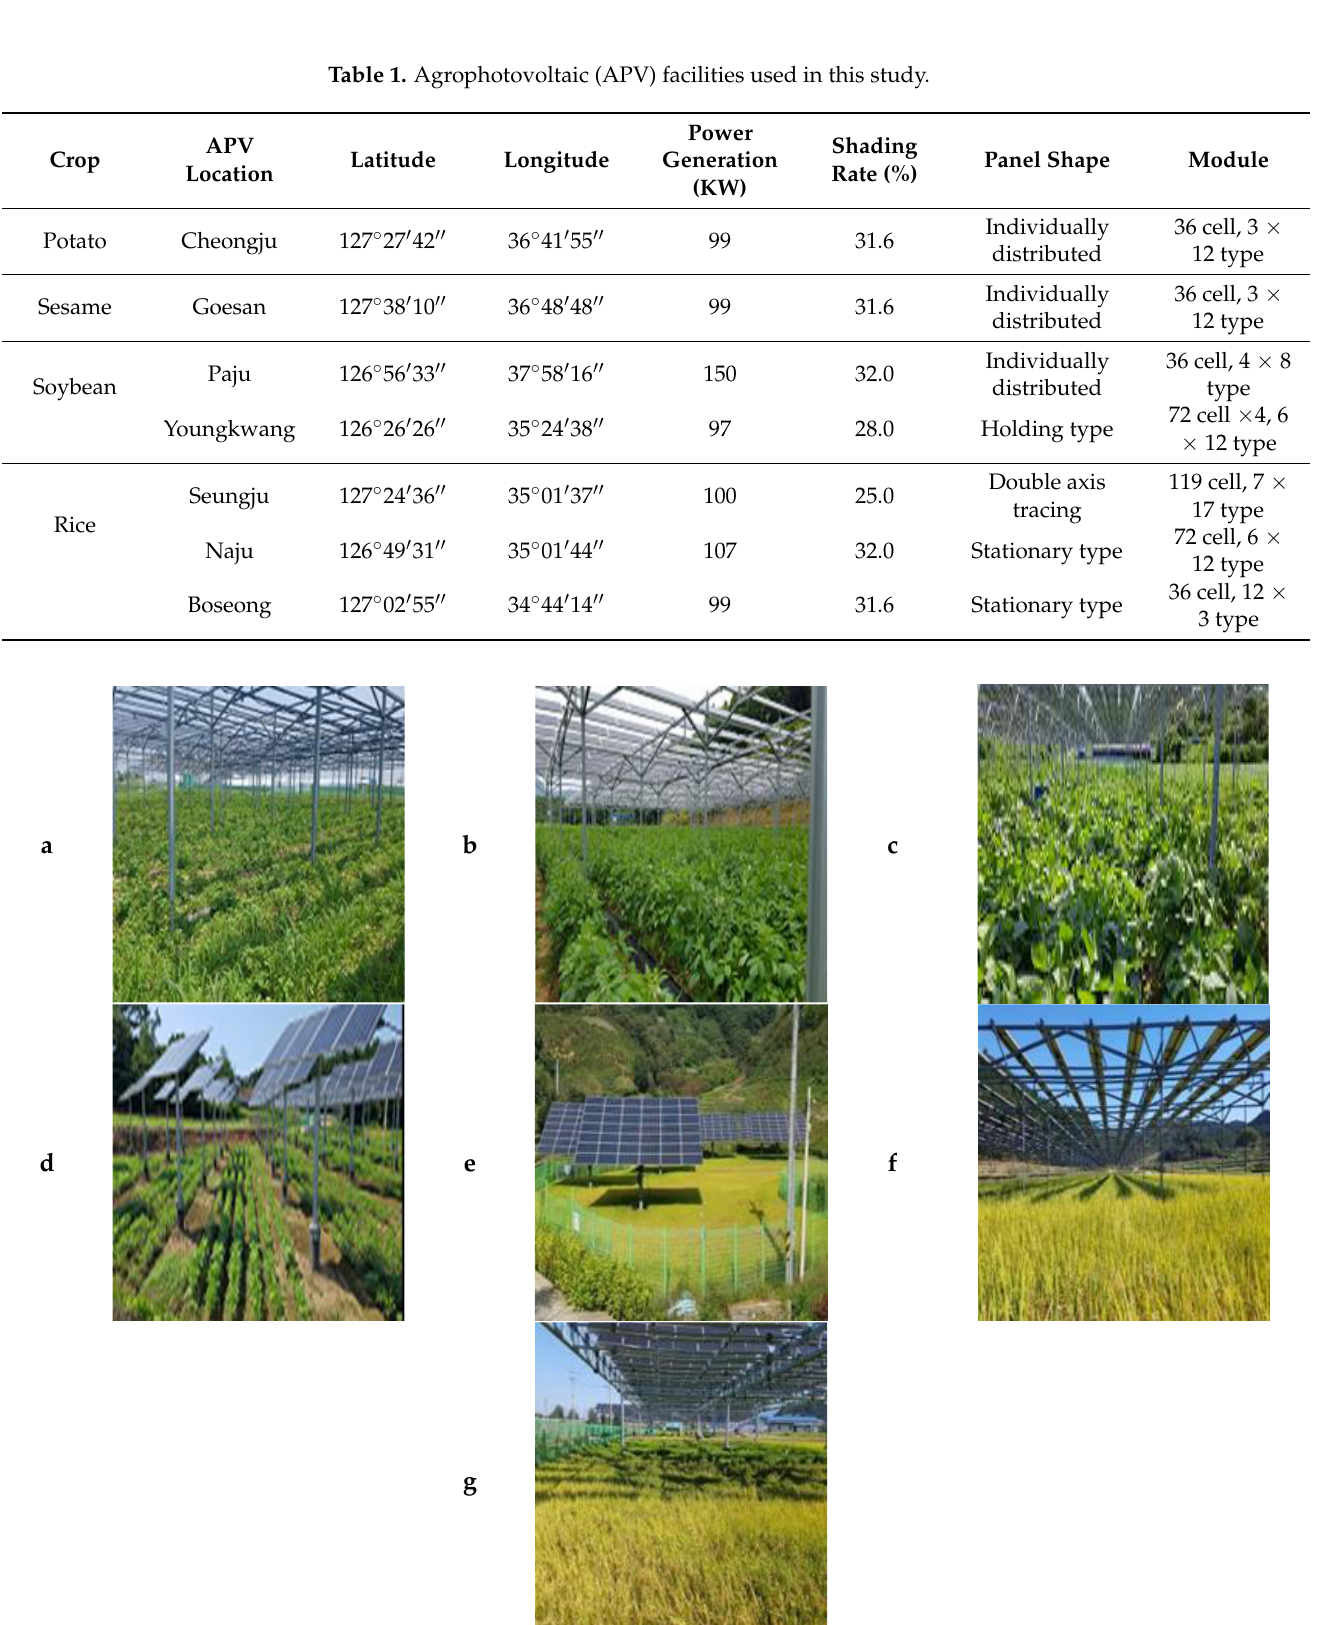
Figure 1. APV facilities used in this study ( a ), potato in Cheongju; ( b ), sesame in Gaesan; ( c ), soybean in Paju; ( d ), soybean in Youngkwang; ( e ), rice in Seungju, ( f ), rice in Boseong; ( g ), rice in Naju.